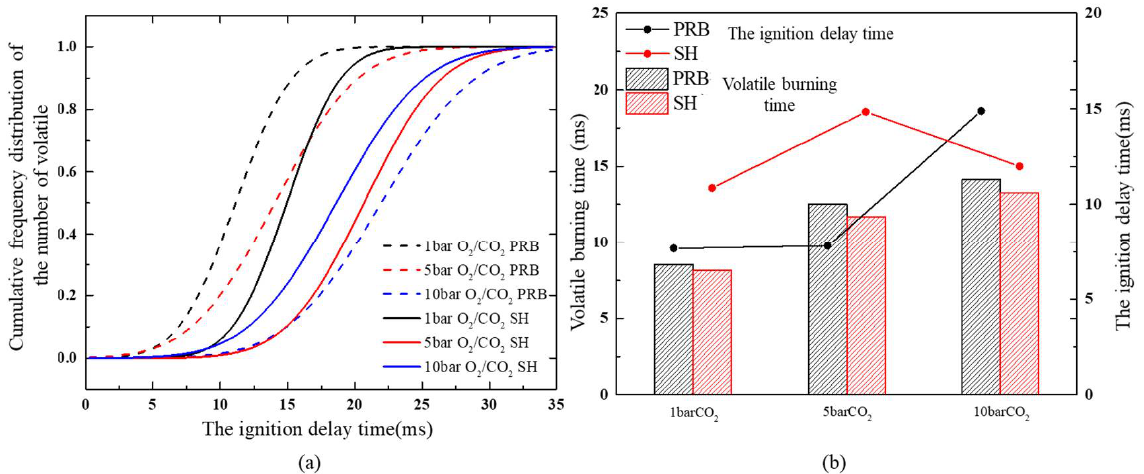
Figure 13. Burning time characteristics of Shenhua bituminous coal and PRB sub-bituminous coal under different working conditions: ( a ) cumulative frequency curve of volatile particle distribution; ( b ) volatile burning time.